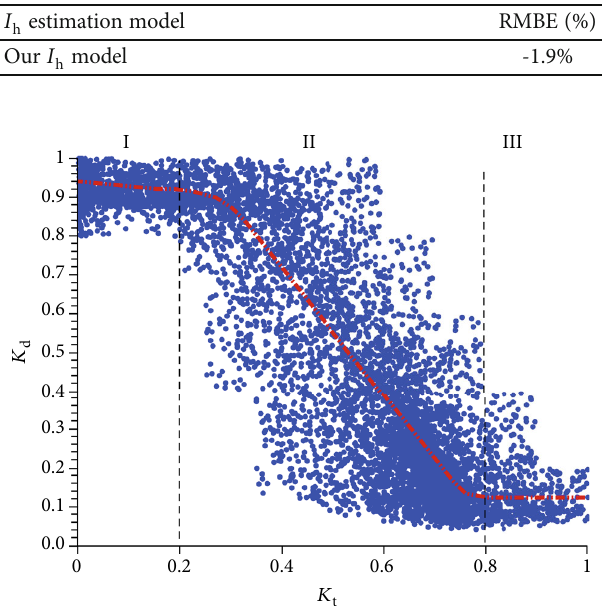
h model validation test.